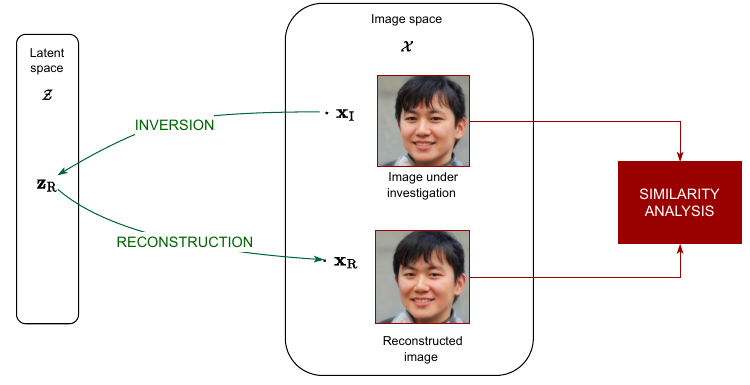
Figure 1. Overview of the inversion-based